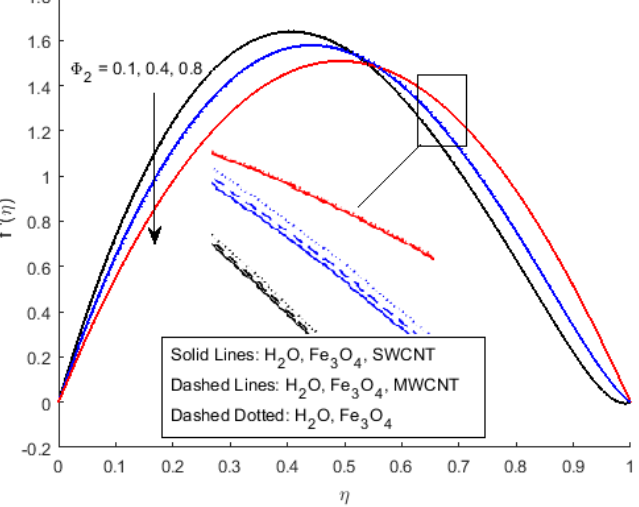
Figure 4. Effect of f (cid:48) ( η ) for Φ 2 and fixed values of S = 1.5, Re m = 2.5, Ha = 0.4, Pr = 6.2, Ec = 0.5, δ = 0.4, Φ 1 = 0.02, m =